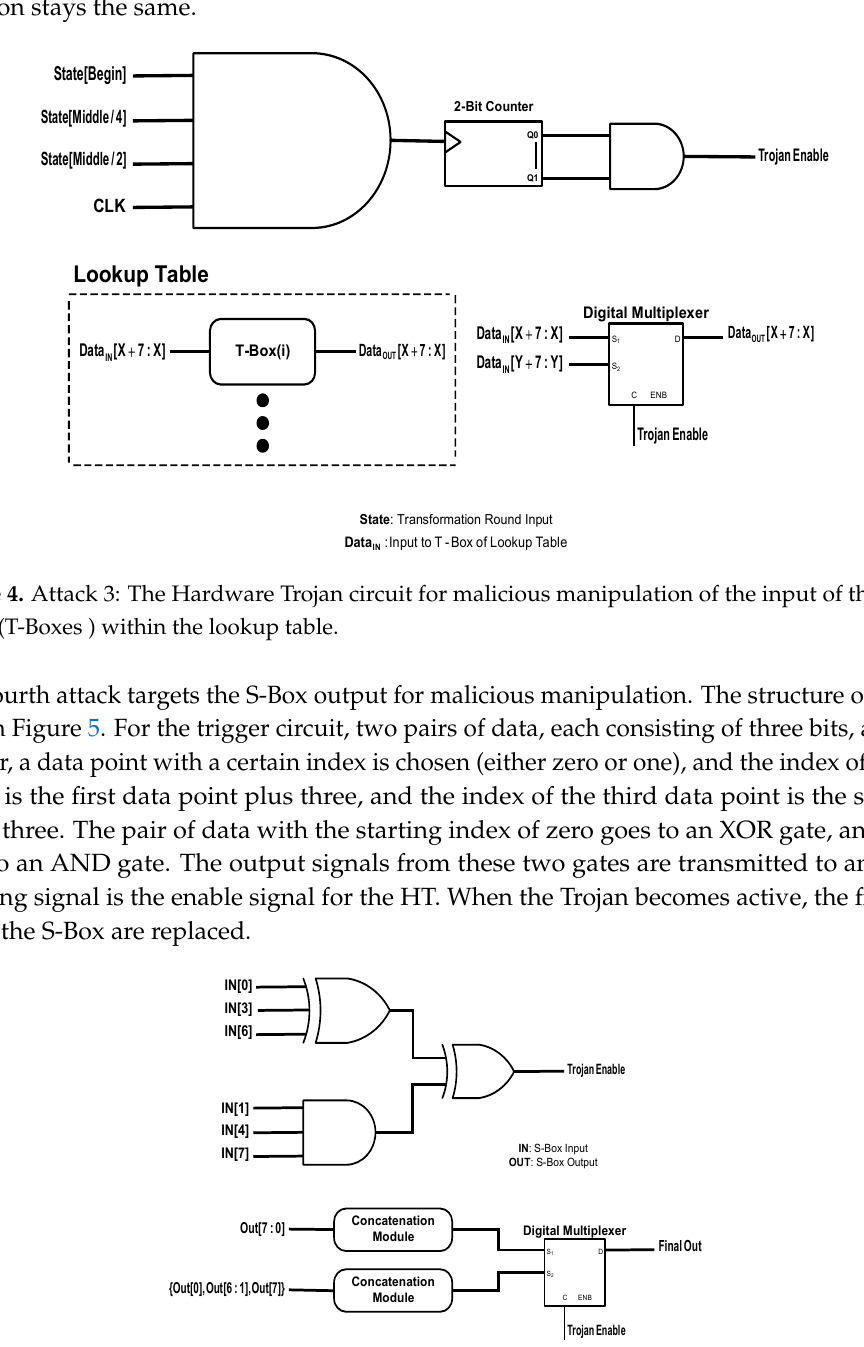
Figure 5. Attack 4: The Hardware Trojan circuit for malicious manipulation of the output of the substitution-box